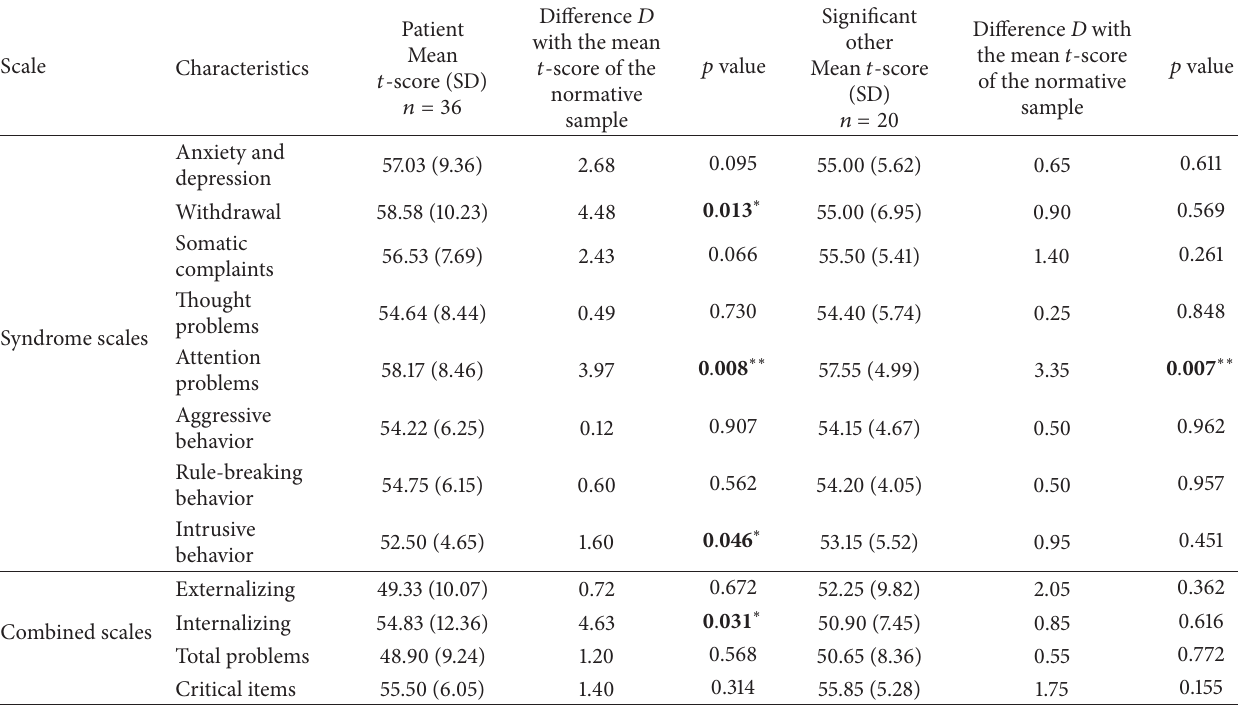
Table 3: Comparison of self-rating and proxy-rating with the normative sample.